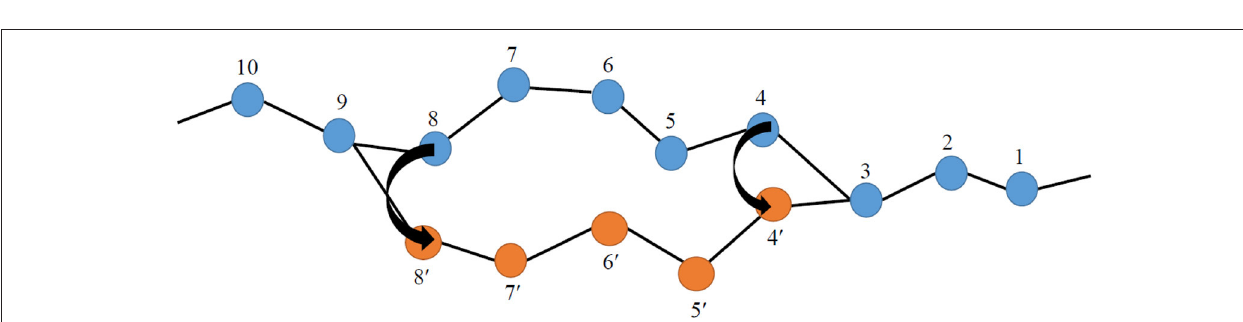
Frontiers in Physics |